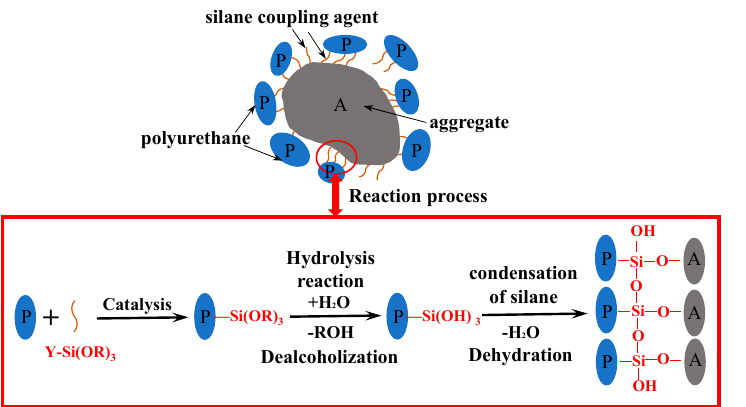
Figure 3. Reaction process of silane coupling agent. Table 2. Mix proportion of modified polyurethane